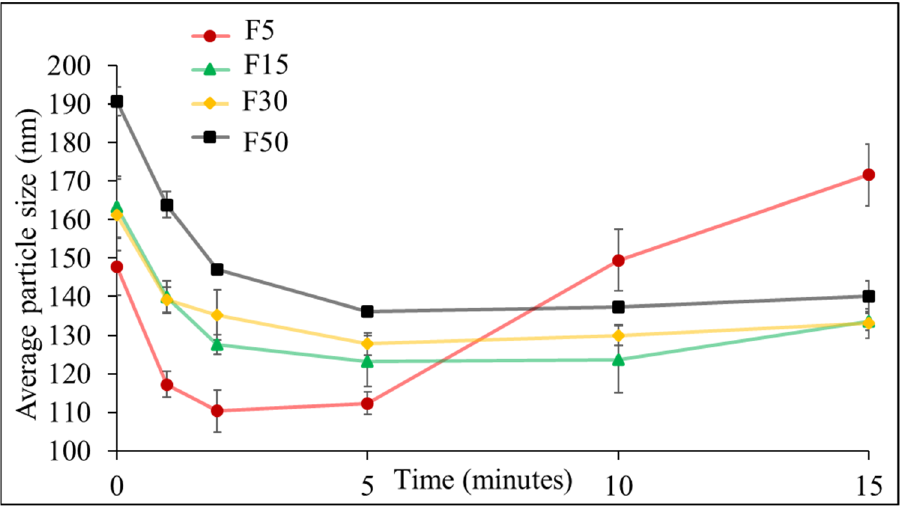
Figure 3. Effect of US time on particle size of blank NLCs.